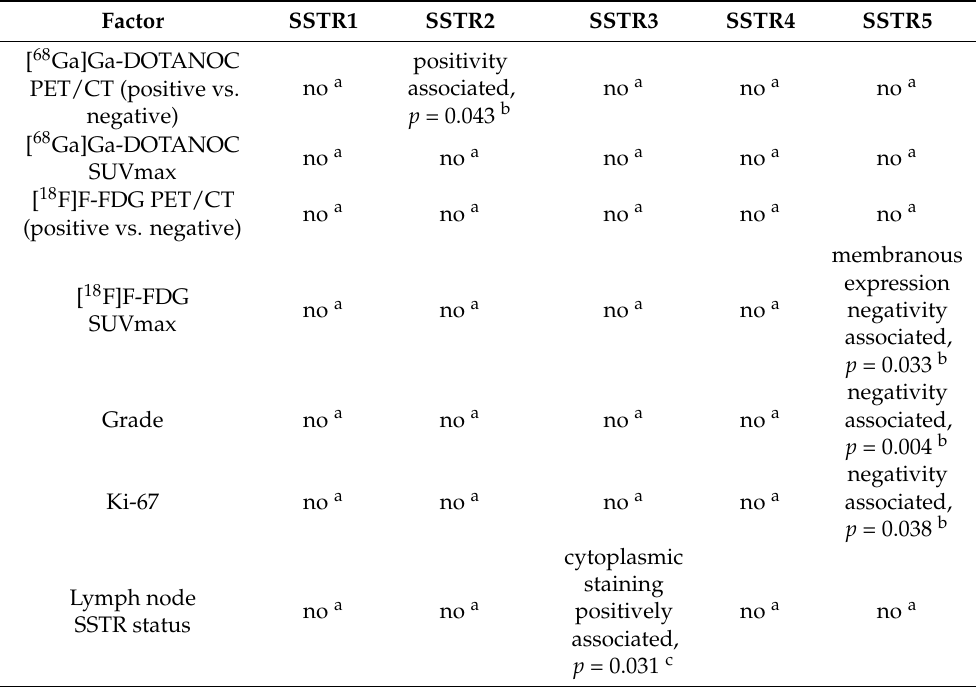
Table 4. Summary table of somatostatin receptor (SSTR) expression association with PET/CT imaging results and clinicopathological